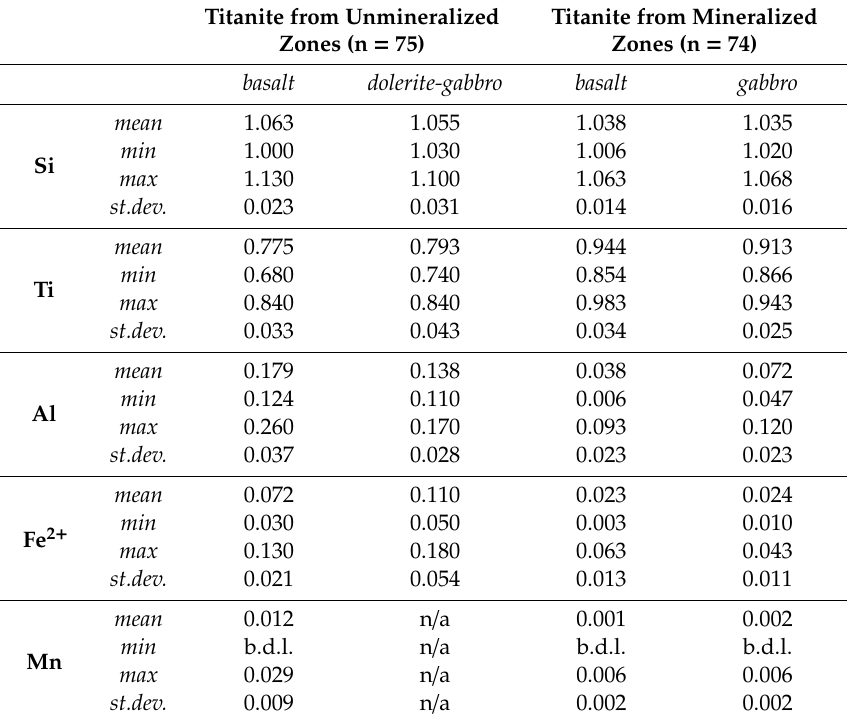
Figure 3. Titanite from mineralized zones shows enrichment in Ti content as well as a slightly higher Fe/Al ratio and depletion in Al, Fe, Mn, F, Cu and Zn contents compared to unmineralized zones. Table 2. Recalculation of titanite formula, using a fixed number of five oxygens.